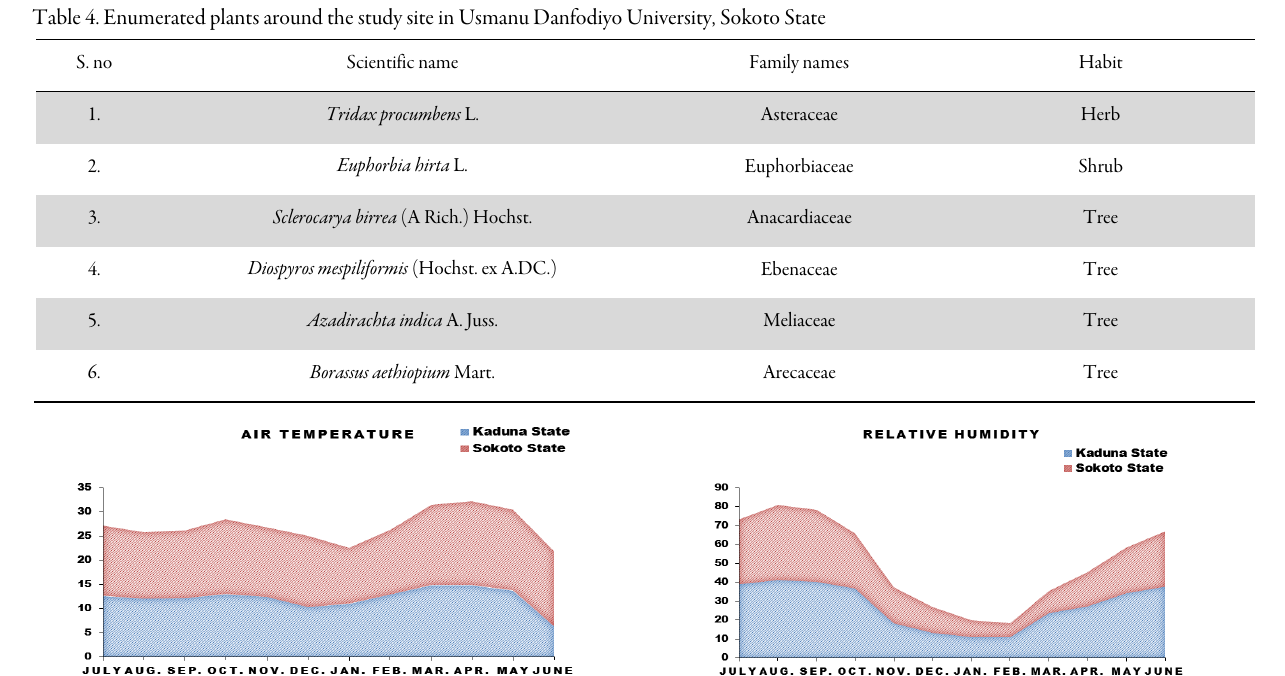
Fig. 4. Mean monthly air temperature values ( o C) in Kaduna and Sokoto States